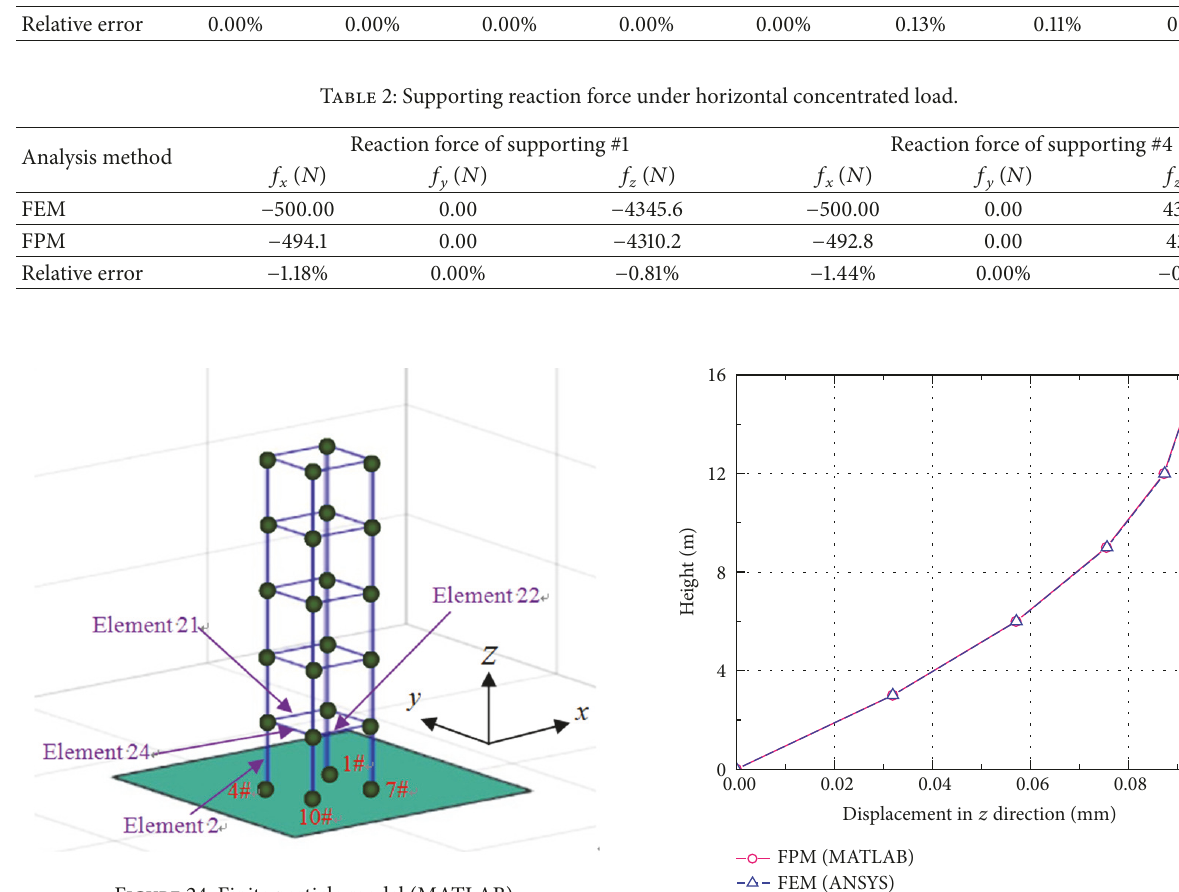
Figure 24: Finite particle model (MATLAB).